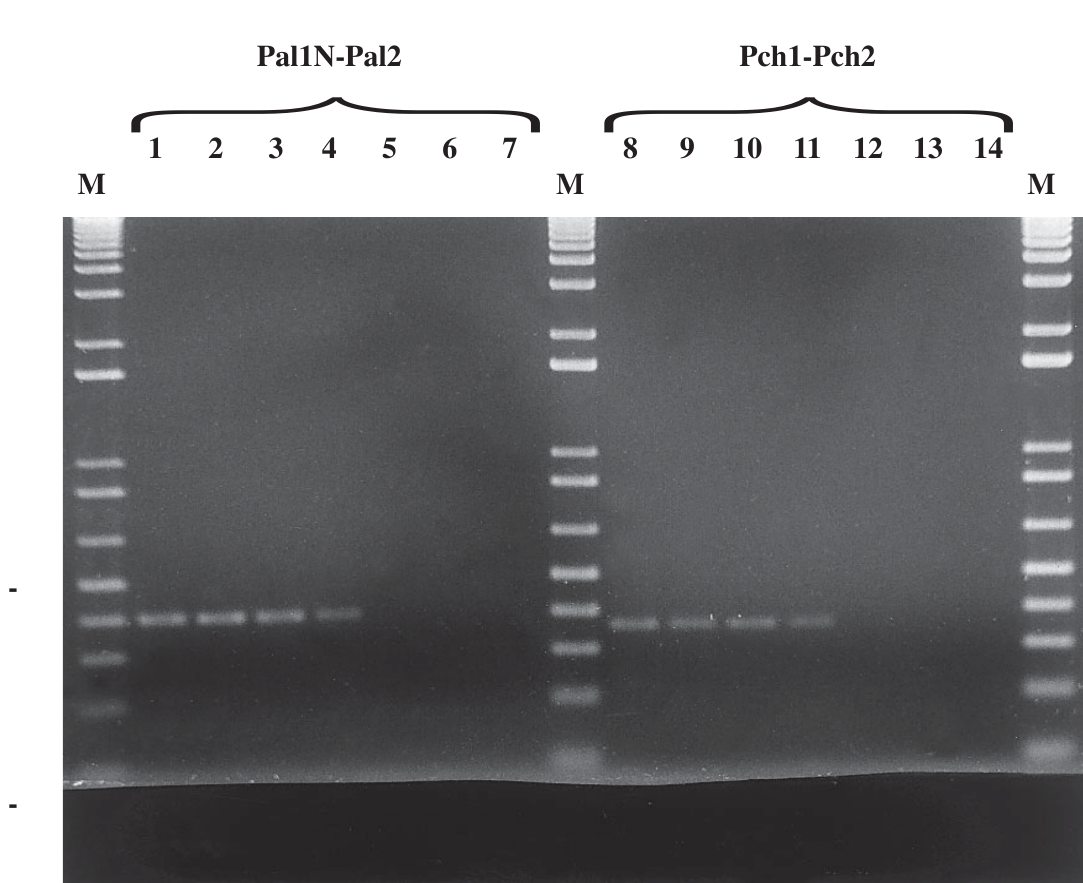
Fig. 4. Gel electrophoresis of the PCR products obtained with primer pairs Pal1N-Pal2 (lanes 1-7) and Pch1-Pch2 (lanes 8-14), using a tenfold dilution series of DNA template. Lanes 1-5, 10 ng to 1 pg of P. aleophilum 157 DNA; lane 6, 10 ng of P. chlamydosporum 56 DNA; lanes 8 to 12, 10 ng to 1 pg of P. chlamydosporum 56 DNA; lane 13, 10 ng of P. aleophilum 157 DNA; lanes 7 and 14, negative control of sterile distilled water; lane M, 1Kb Plus DNA Ladder (Gibco-BRL, Life